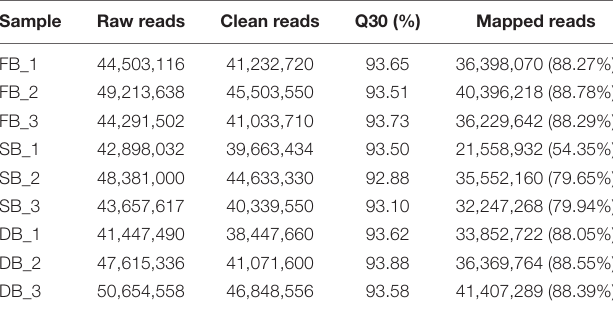
TABLE 1 | Quality of transcriptomic